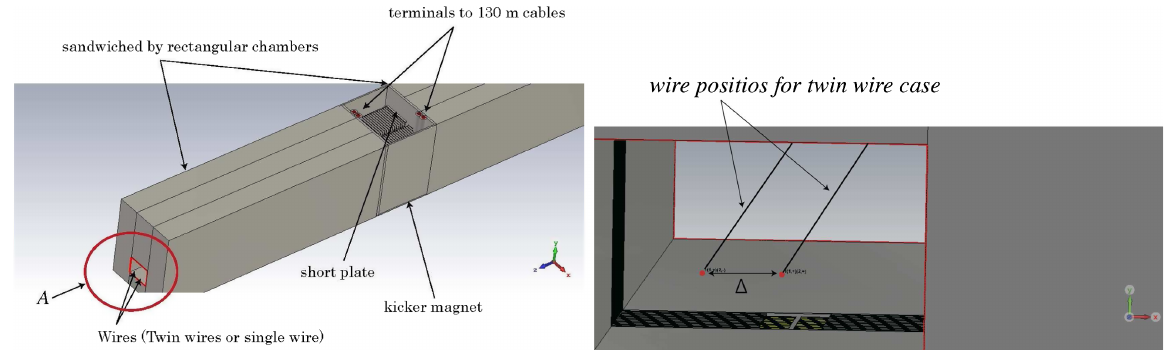
FIG. 8. Simulation setup (left) for measurements of the longitudinal or horizontal beam impedances using the wire method. The scaled up figure of area A in the left picture is shown in the right picture. The wire radius is ρ w ¼ 80 μ m and the twin-wire separation is Δ ¼ 60 mm. For the measurements of the longitudinal beam impedance, the single wire is positioned at the center of the